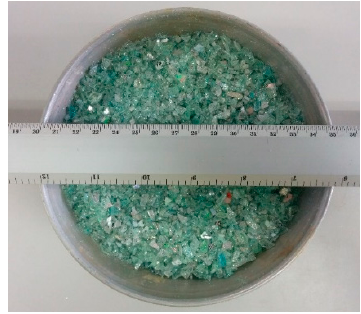
Figure 2. Shredded CDs and DVDs ready to be used as aggregate in the mixtures.